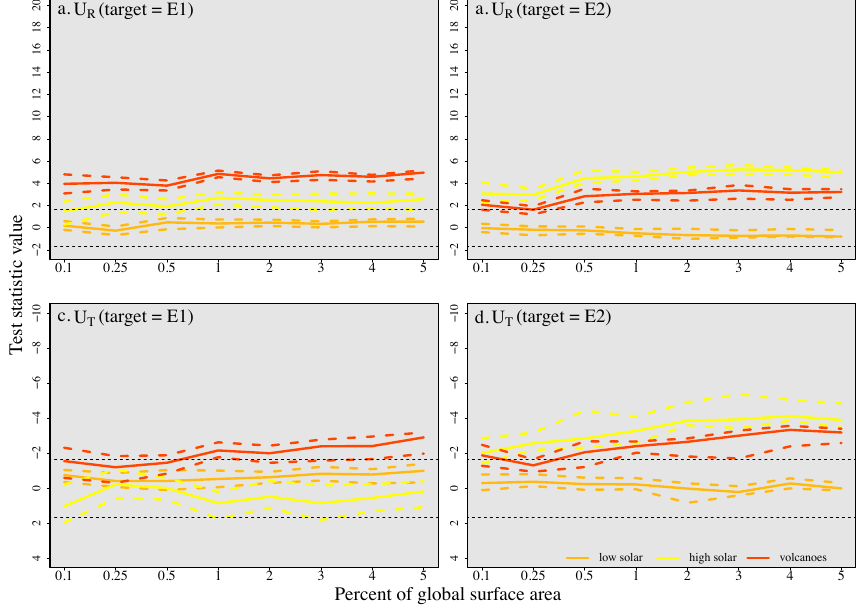
Fig. 6. U R correlation (top panels) and U T distance (bottom panels) measures for volcanic (red), low (light orange) and high (yellow) solar forcing simulations, against increasing % global surface area coverage. The left panels are for E1 as target, right panels E2 as target. The 5% significance level is shown with dashed lines. The filled coloured lines denote the median value, with the dashed coloured lines representing the upper and lower